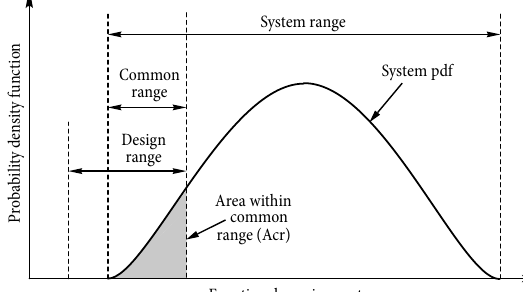
Fig. 2. Design range, system range, common range and system pdf for a FR